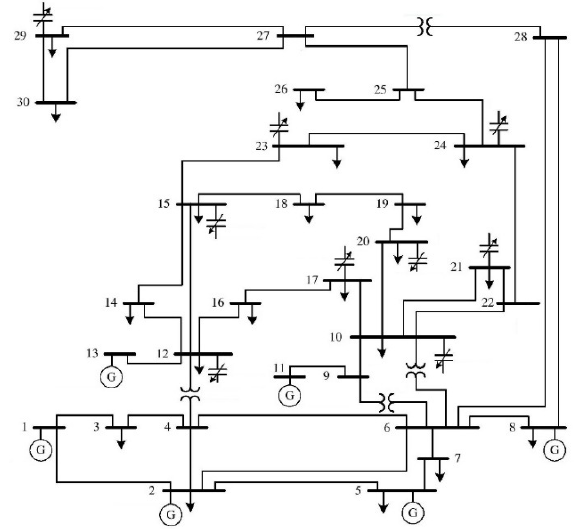
Figure 5. IEEE 30-bus test system single-line diagram. Table 6. Results of OPF for IEEE 30-bus test system on Case 1.